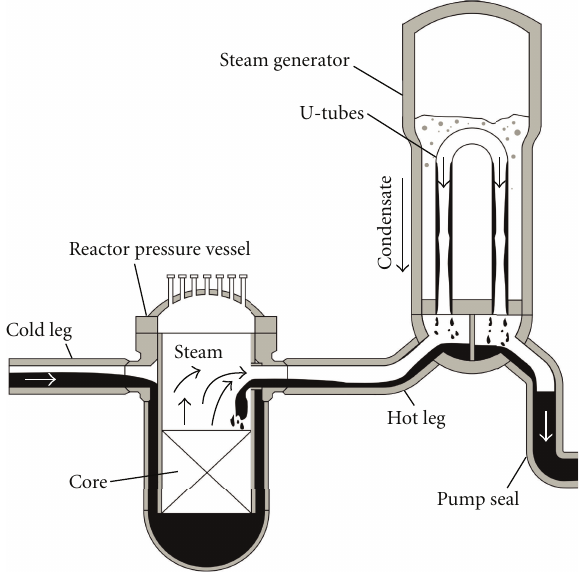
Figure 1: Konvoi German PWR piping configuration and reflux condensation flow paths